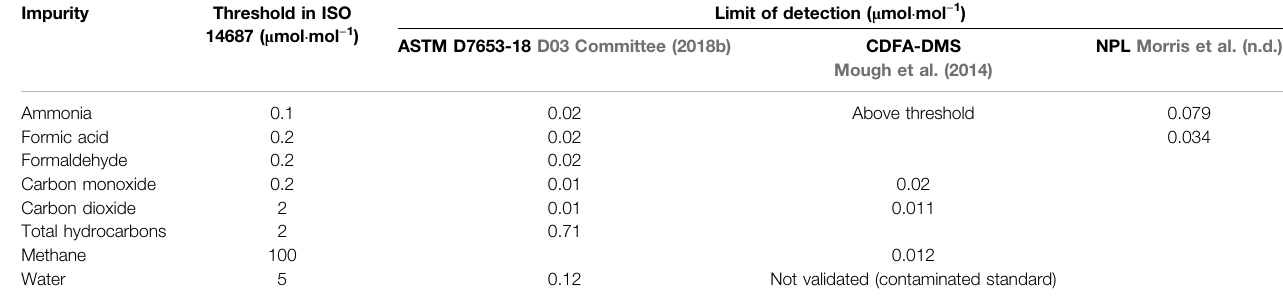
TABLE 8 | Detection limit per impurity with FTIR in ASTM D7653-18, for CDFA-DMS and NPL. Impurity